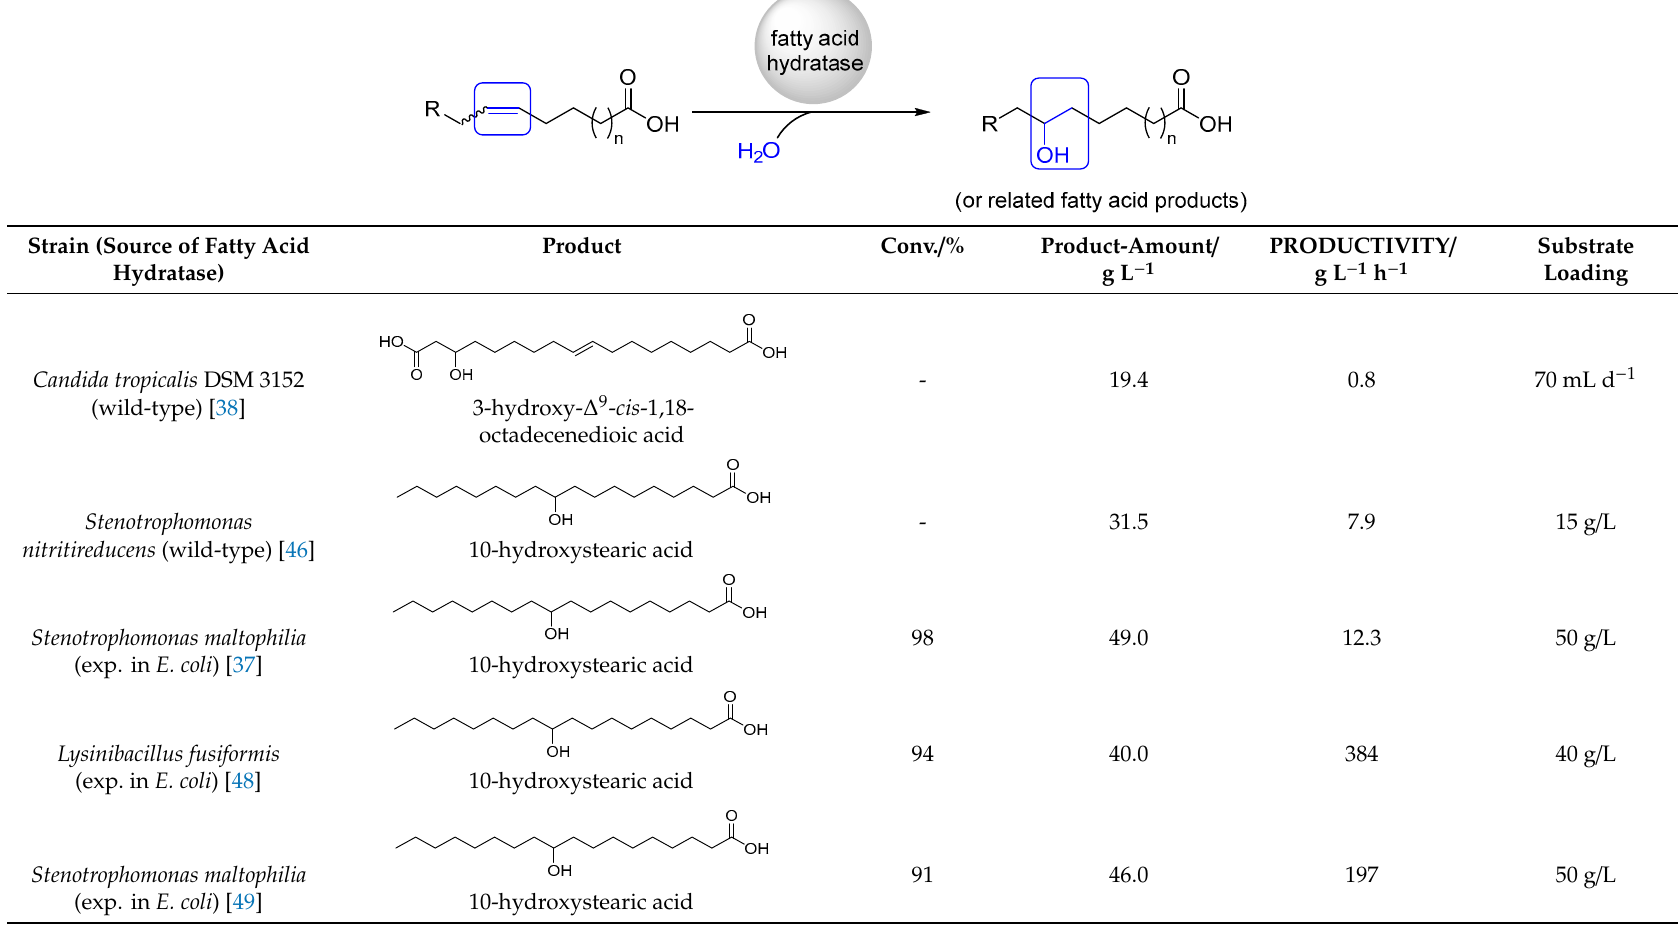
Table 1. Summary of fatty acid hydratases and resulting products synthesized on multi gram-scale. Exp. in E. coli : expressed in E. coli ; —: no information was given.